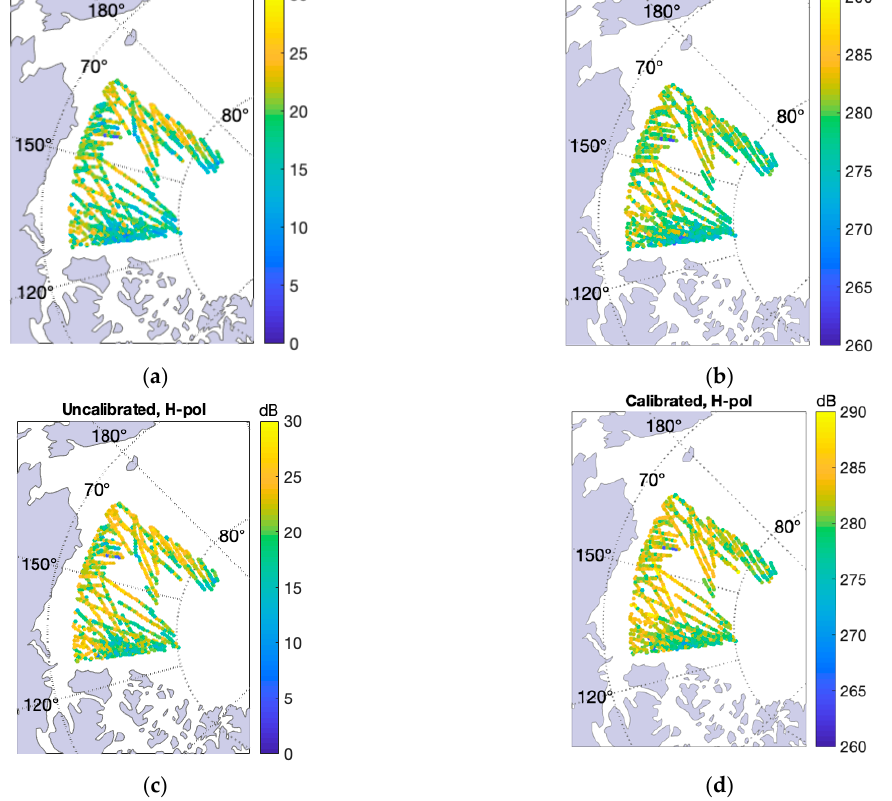
Figure 19. SMAP-R measurements for February 2018, ( a ) uncalibrated V-pol and ( b ) calibrated V-pol, and ( c ) uncalibrated H-pol and ( d ) calibrated H-pol. Calibration includes both the correction of the GPS transmitter variability (collocating direct power information from CYGNSS) and the correction of the e ff ect of the SMAP high gain antenna. Note that calibrated values correspond to radar cross section values after applying calibration Equation (5) under a coherent